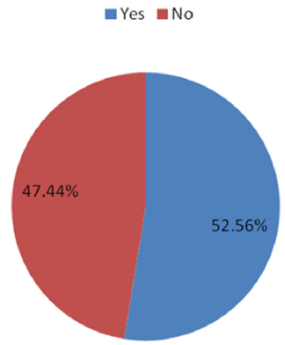
Figure 4. Replies to the question, “Did you see a renewable energy technology as a solar or wind